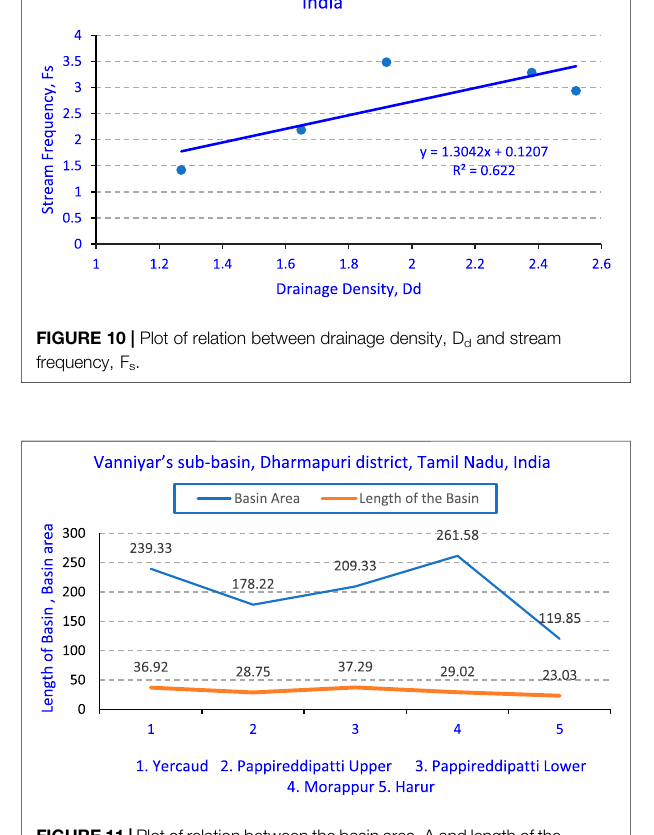
FIGURE 11 | Plot of relation between the basin area, A and length of the basin, L b .